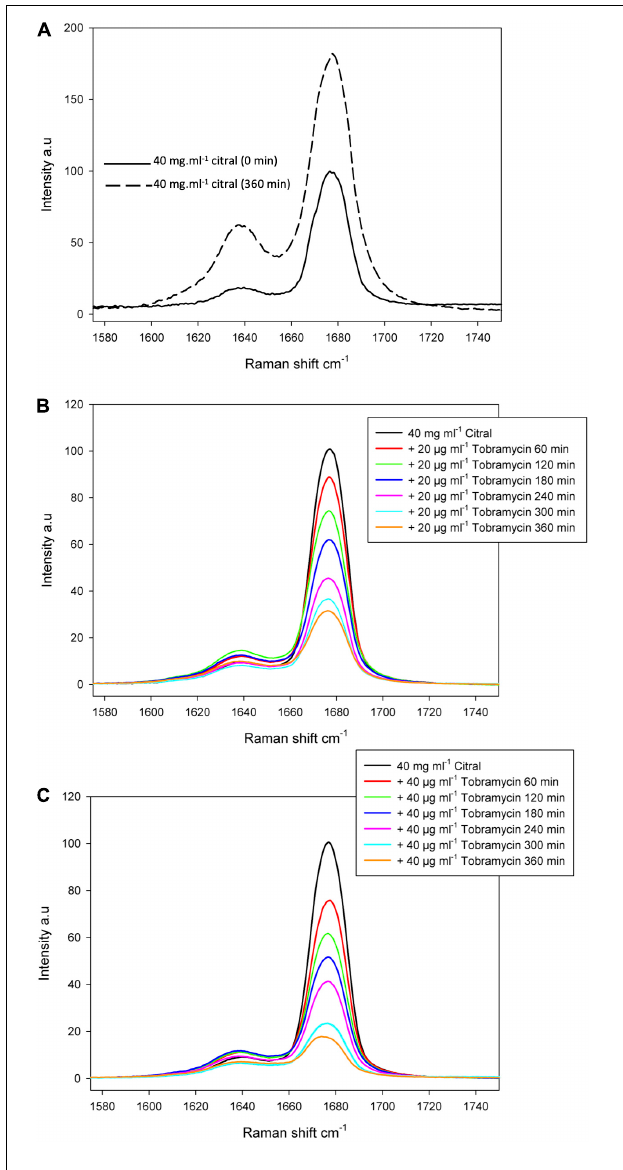
FIGURE 7 | Raman spectrum of the citral C=O band. Raman spectrum of the citral C=O band was centered at 1676 cm - 1 and measured before and after 360 min at 37 ◦ C, to confirm citral can be still detected after this incubation time (A) . The reaction between citral and tobramycin was followed over the same period of 6 h by adding 20 µ g/mL (B) or 40 µ g/mL of tobramycin (C)